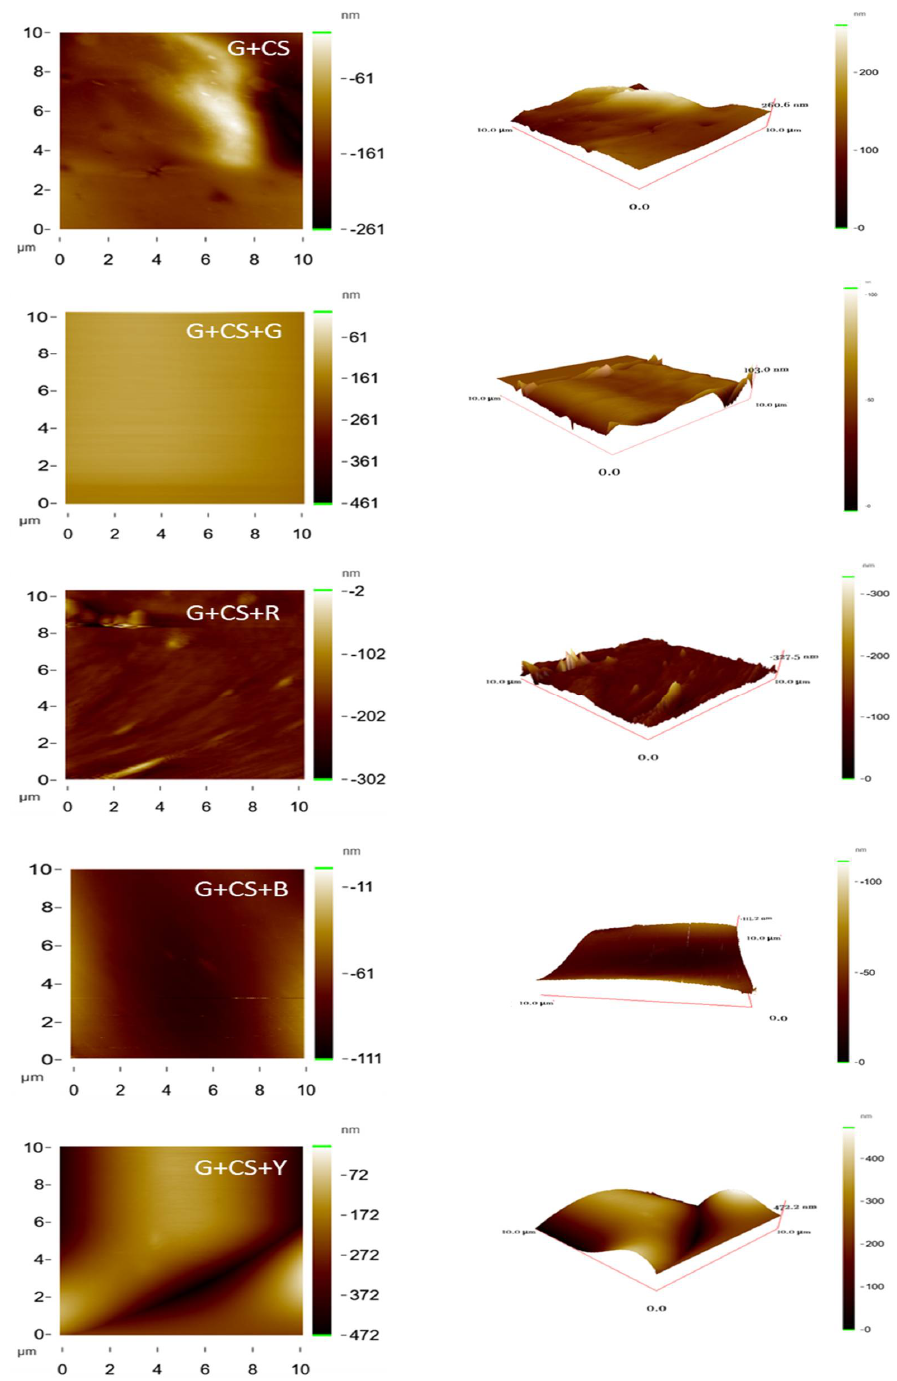
Figure 8. Typical AFM images showing the two-dimensional structure of AFM images of gelatin– cornstarch-based edible films with and without food color and showing the three-dimensional structure of AFM images of gelatin–cornstarch-based edible films with and without food color.